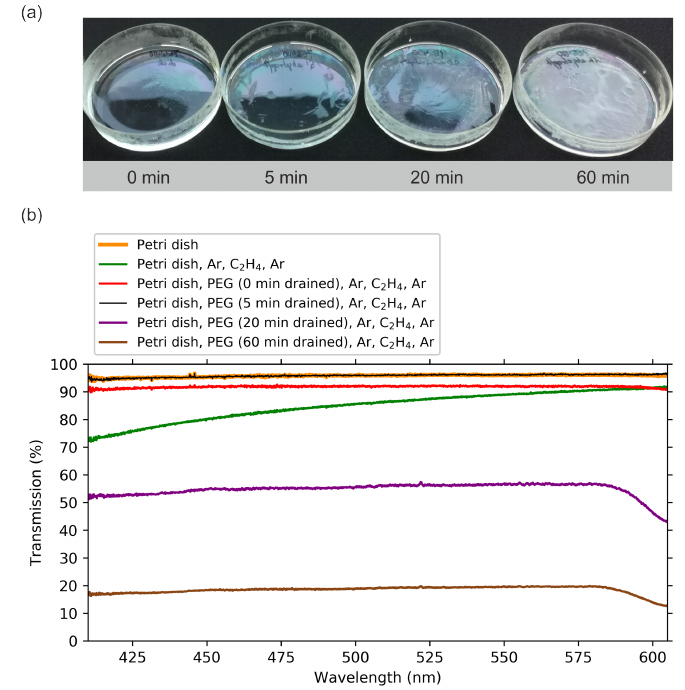
Figure 4. ( a ) Photographs and ( b ) optical transmission spectra of plasma-coated PEG held in Petri dishes for different draining durations. There was no PDMS backing added and the samples had not yet been lifted off the Petri